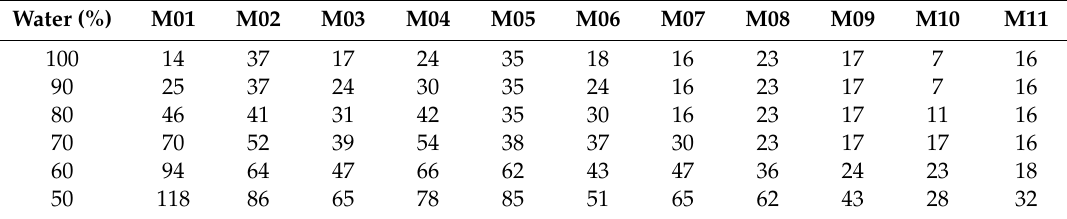
Table 3. Shadow prices of water in the irrigation modules of the Irrigation District 011 (US$ / dam 3